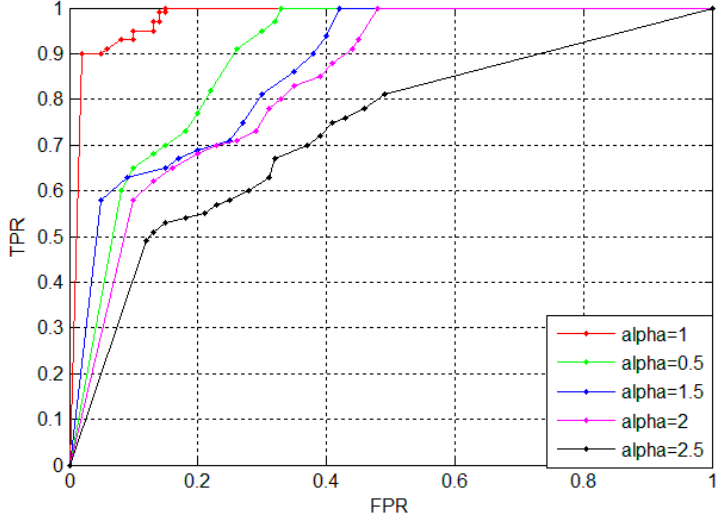
Figure 6. The relationship between alpha and ROC.